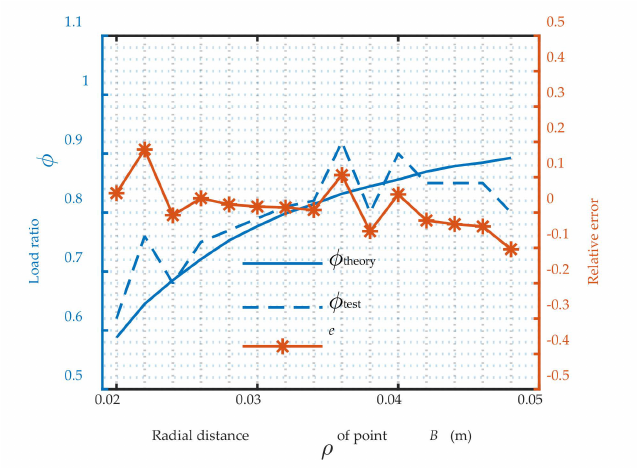
Figure 27. Load ratio estimation results in configuration I with θ >